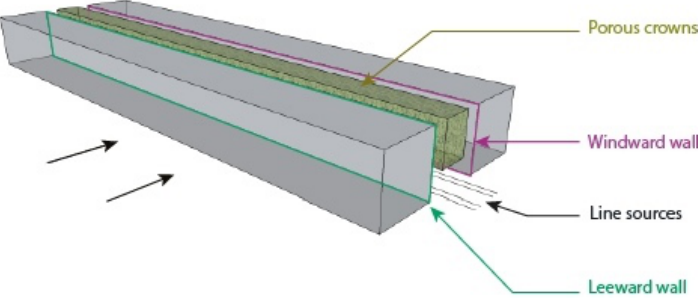
Figure 6. Configuration of street canyon with tree planting case.